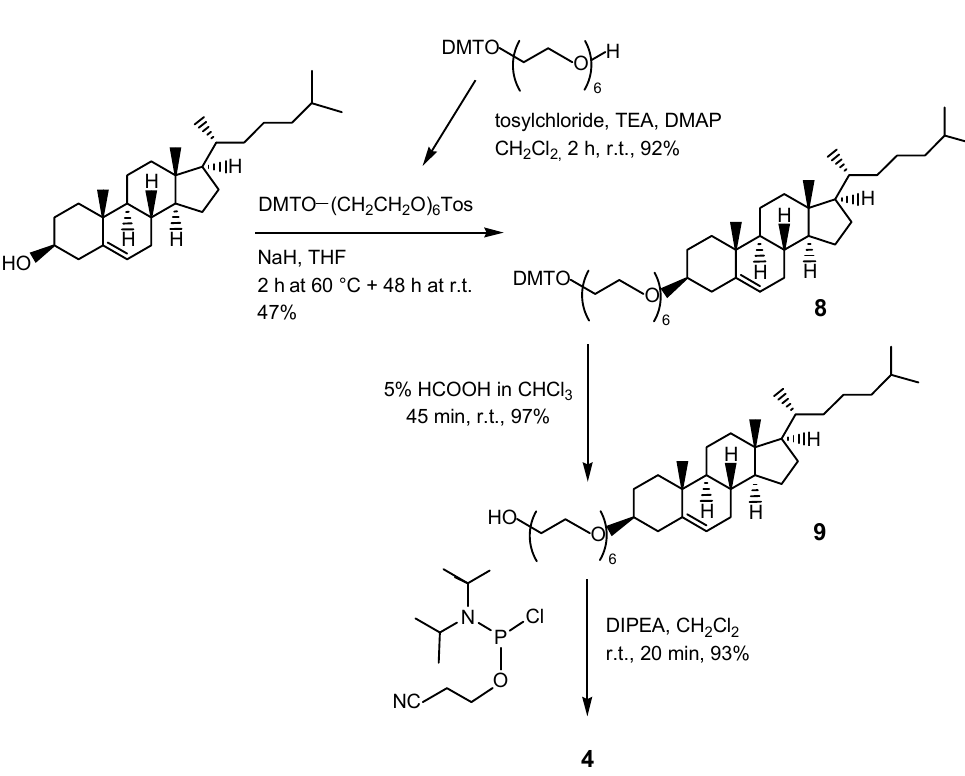
Scheme 2. Synthesis of phosphoramidite derivative 4